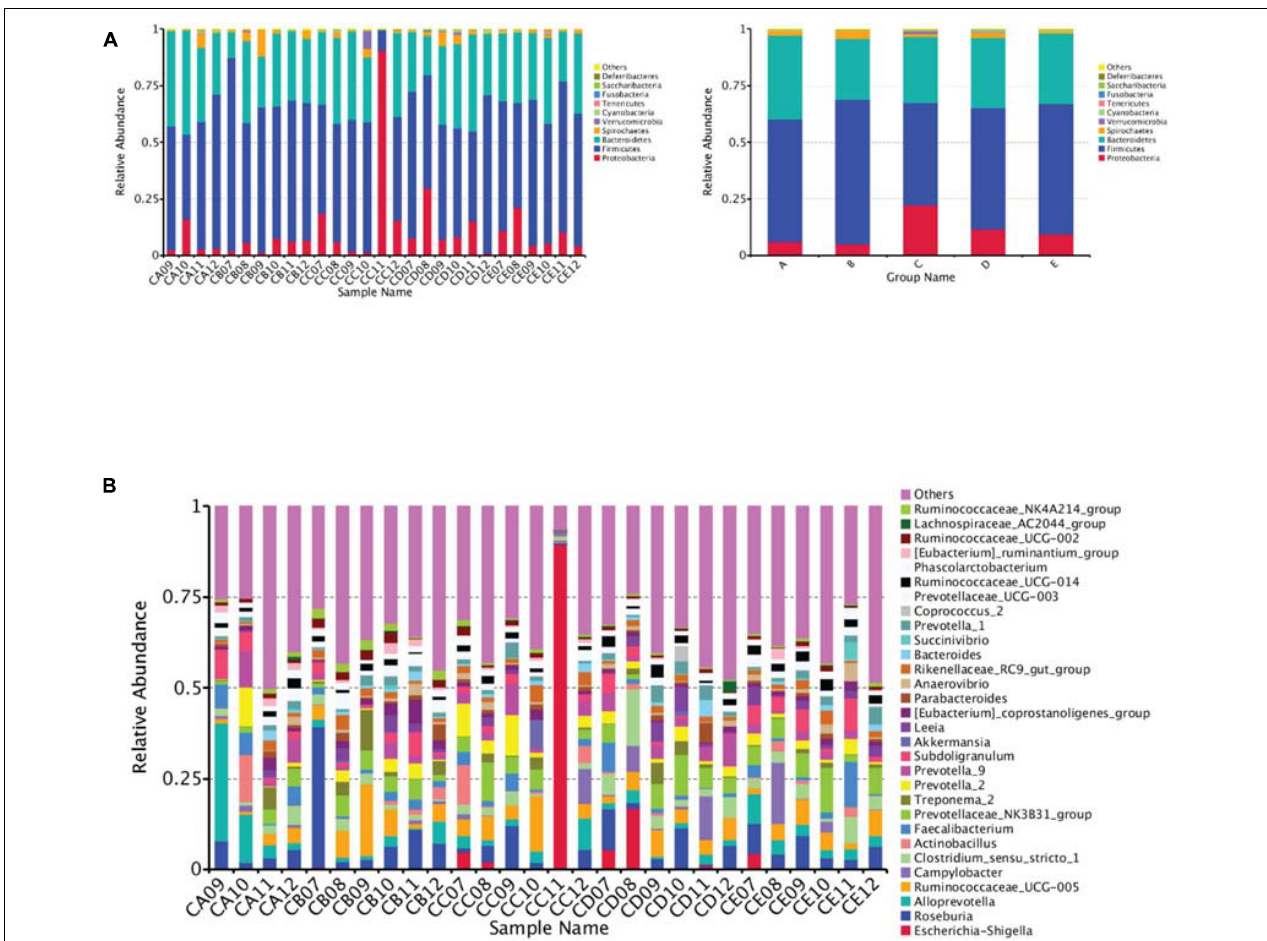
FIGURE 3 | Bar graph showing the top 10 (A) or top 30 (B) phylum level compositions of bacteria. Color-coded bar plot showing the relative abundance of bacterial phyla across the different samples ( A , left) or different groups ( A , right). One representative sequence from a set of related sequences belonging to the same OUT was selected for continuous species annotation with an RDP classifier, and the bacterial composition at the phylum level of each sample was stated and visualized with a histogram. The first C representing it comes from the cecal chyme. The second character represented DAR. DARs of A, B, C, D, and E were 0.00, 0.20, 0.40,0.60, and 0.80,